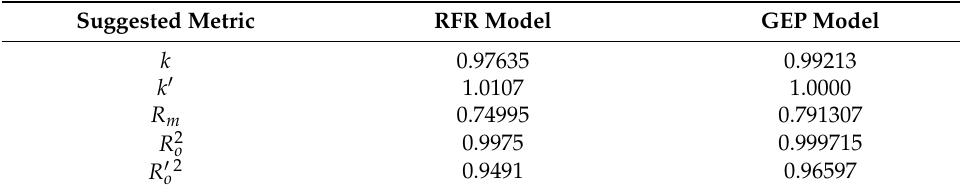
Table 8. Summary of Statistical metrics suggested in literature.